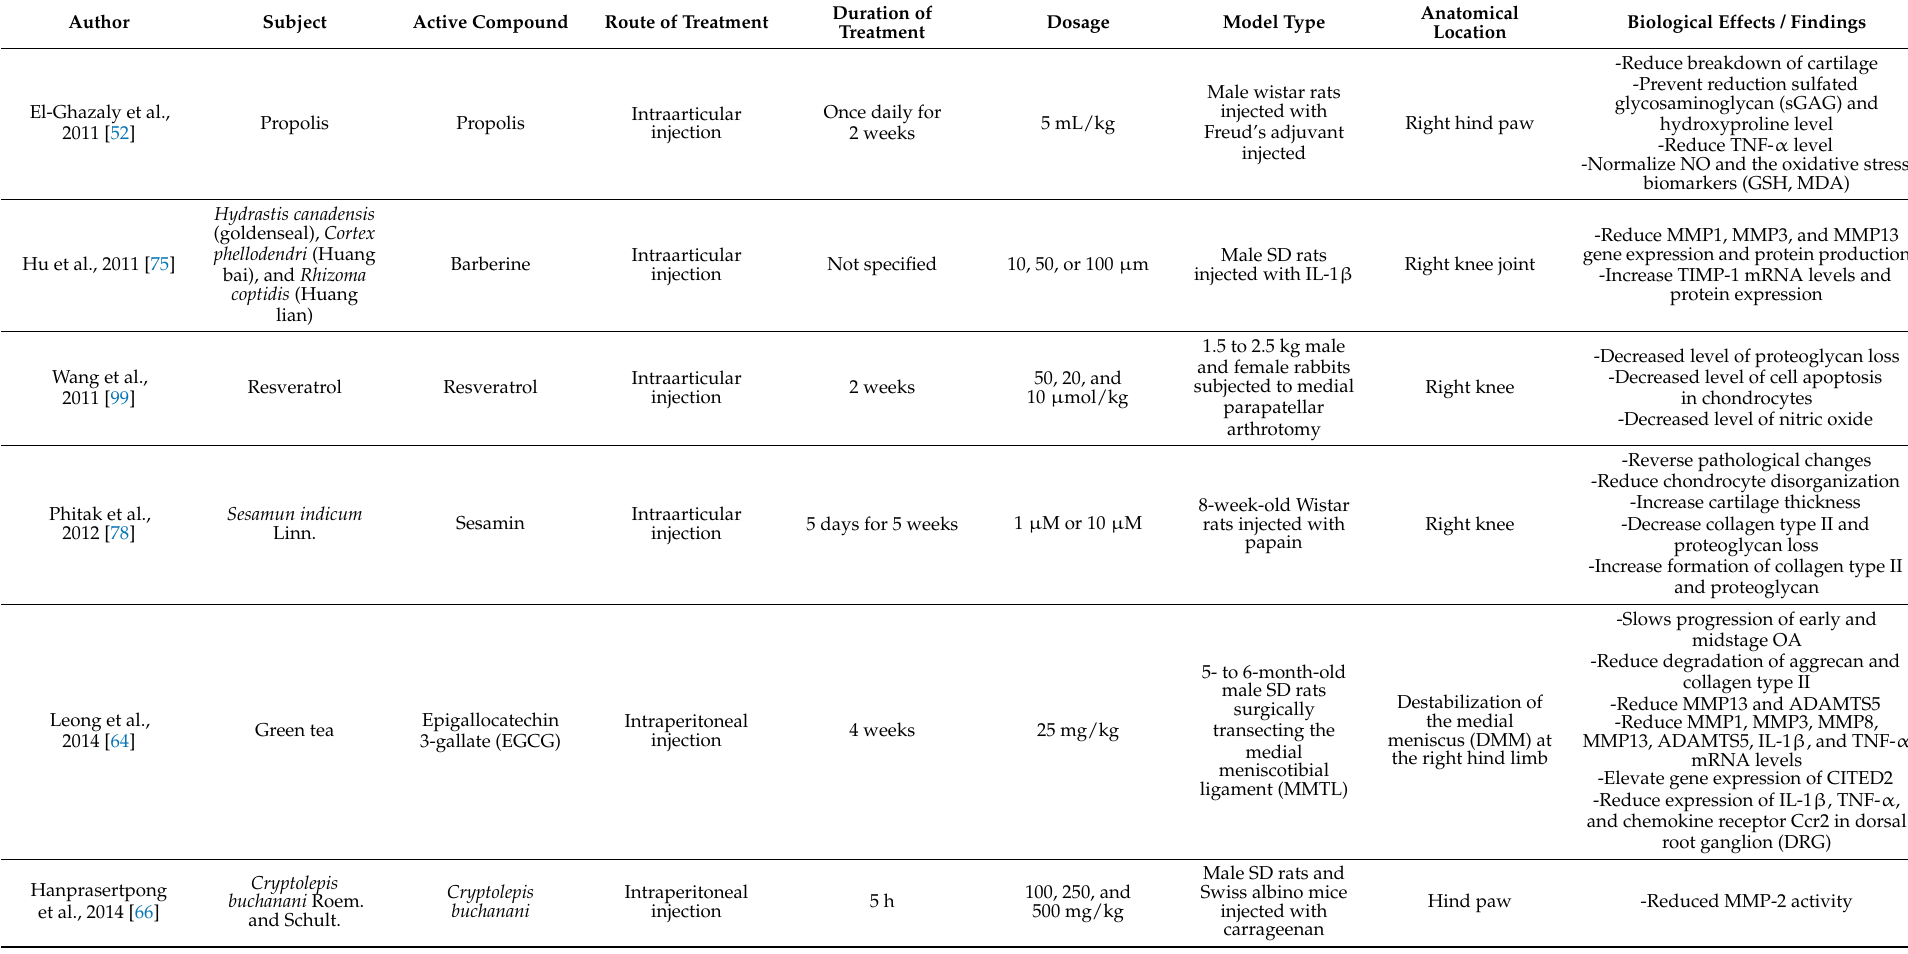
Table 2. In vivo evidence of the effects of natural compounds on